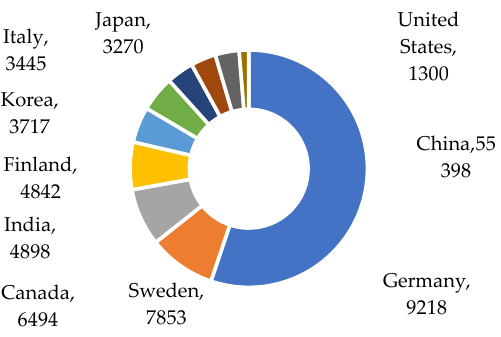
Figure 1. Timber imports (1000 m 3 ).